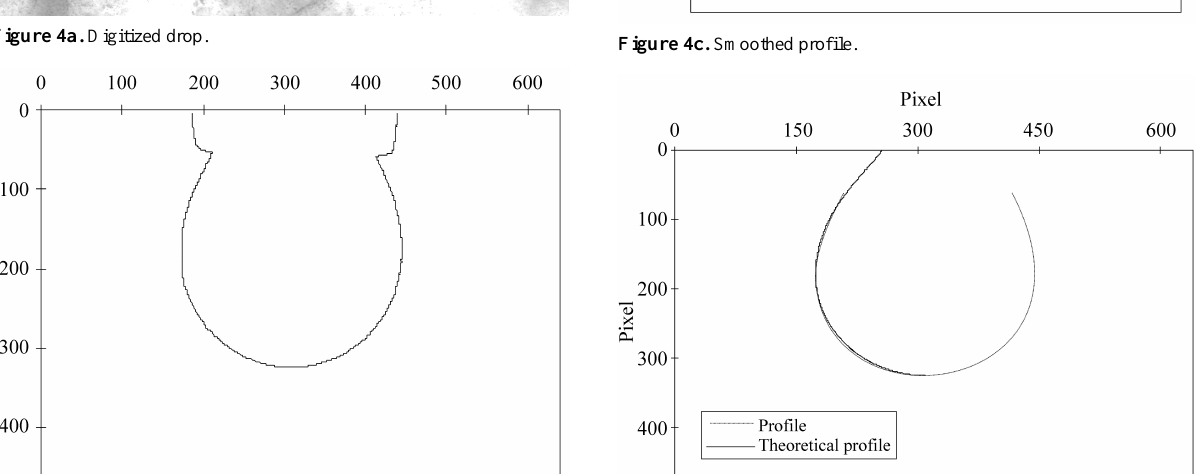
Figure 4d. Superposition of the experimental profile and theoretical profile.